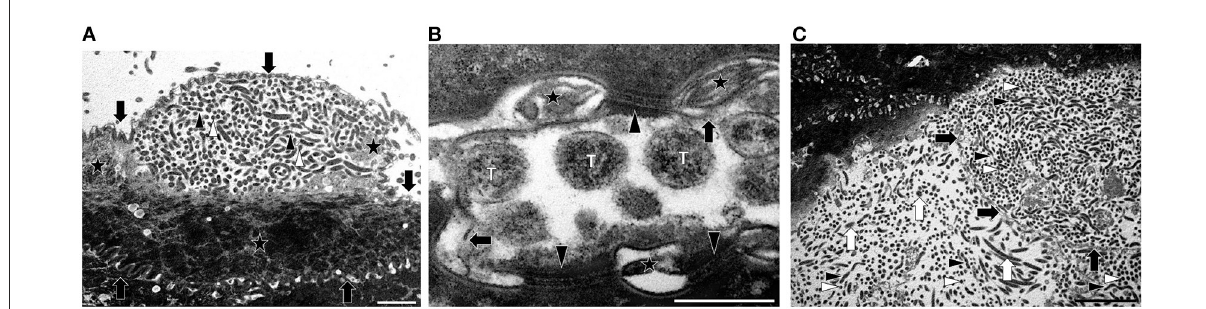
FIGURE3 Transmission electron microscopy (TEM) images of spirochetes from animal No. 5 illustrating the morphology and localization in the infected tissue. (A) Transmission electron micrograph of spirochetes infecting a corneocyte on the surface of the stratum corneum. The membrane of the cell is marked with arrows. Note that the spirochetes (white arrowheads, transverse sections; black arrowheads, longitudinal sections) have not yet invaded the entire cell, and that keratin is still present (stars) (TEM. Magnification: 5.600x, the bar represents 2 µ m) (B) Transmission electron micrograph showing cell membrane damage concurrent to spirochetal infection of a corneocyte. Transversely (T) sectioned spirochetes are visible. The intercellular space is dilated, contains electron-dense material (stars) and the cell membrane of the infected corneocyte shows discontinuities (arrows). Note that there are still intact corneodesmosomes (arrowheads) (TEM. Magnification: 53.000x, the bar represents 500nm). (C) Transmission electron micrograph of spirochetes on the surface of the stratum corneum and inside a corneocyte. There are many spirochetes (white arrowheads, transverse sections; black arrowheads, longitudinal sections) on the surface and inside a largely infected corneocyte. The membrane of the conreocyte is marked with black arrows. On the surface of the stratum corneum smaller amounts of other unspecific bacteria (white arrows) are visible (TEM. Magnification: 3.400x, the bar represents 5 µ